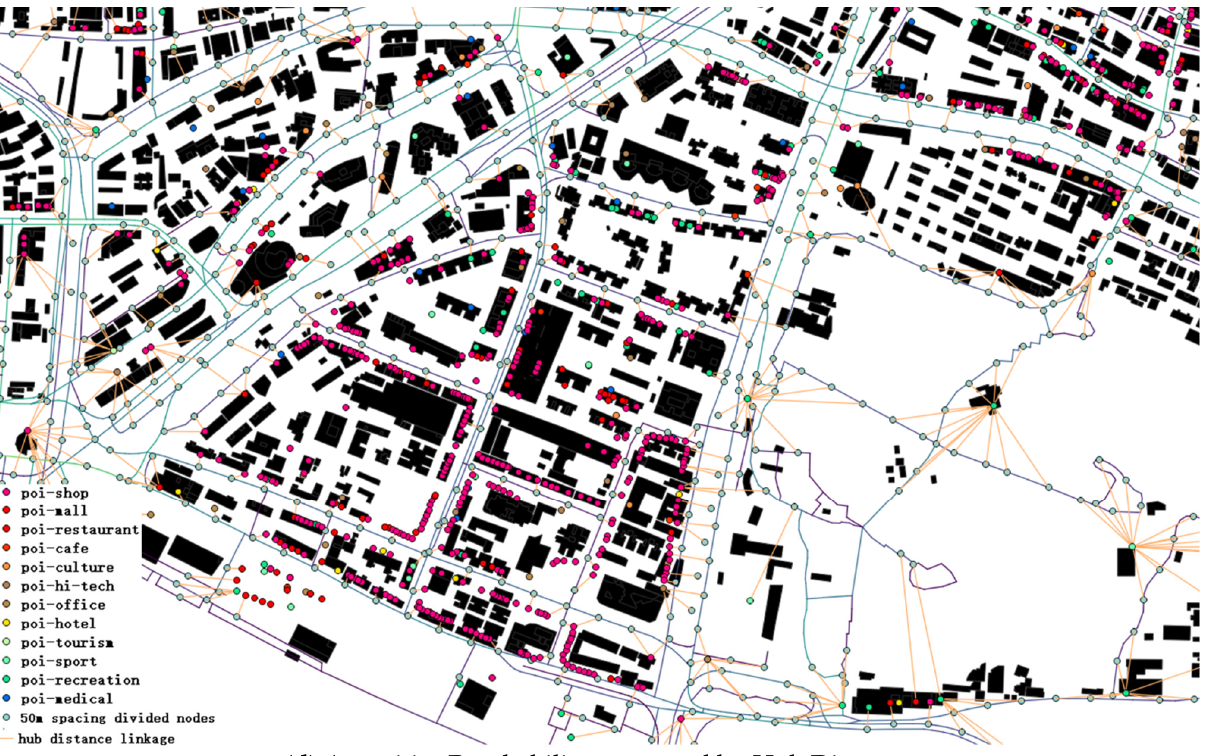
Figure 9. ( a ) Functional density, ( b ) Functional diversity, ( c ) Amenities reachability, and ( d ) Amenities reachability measured by hub distance.